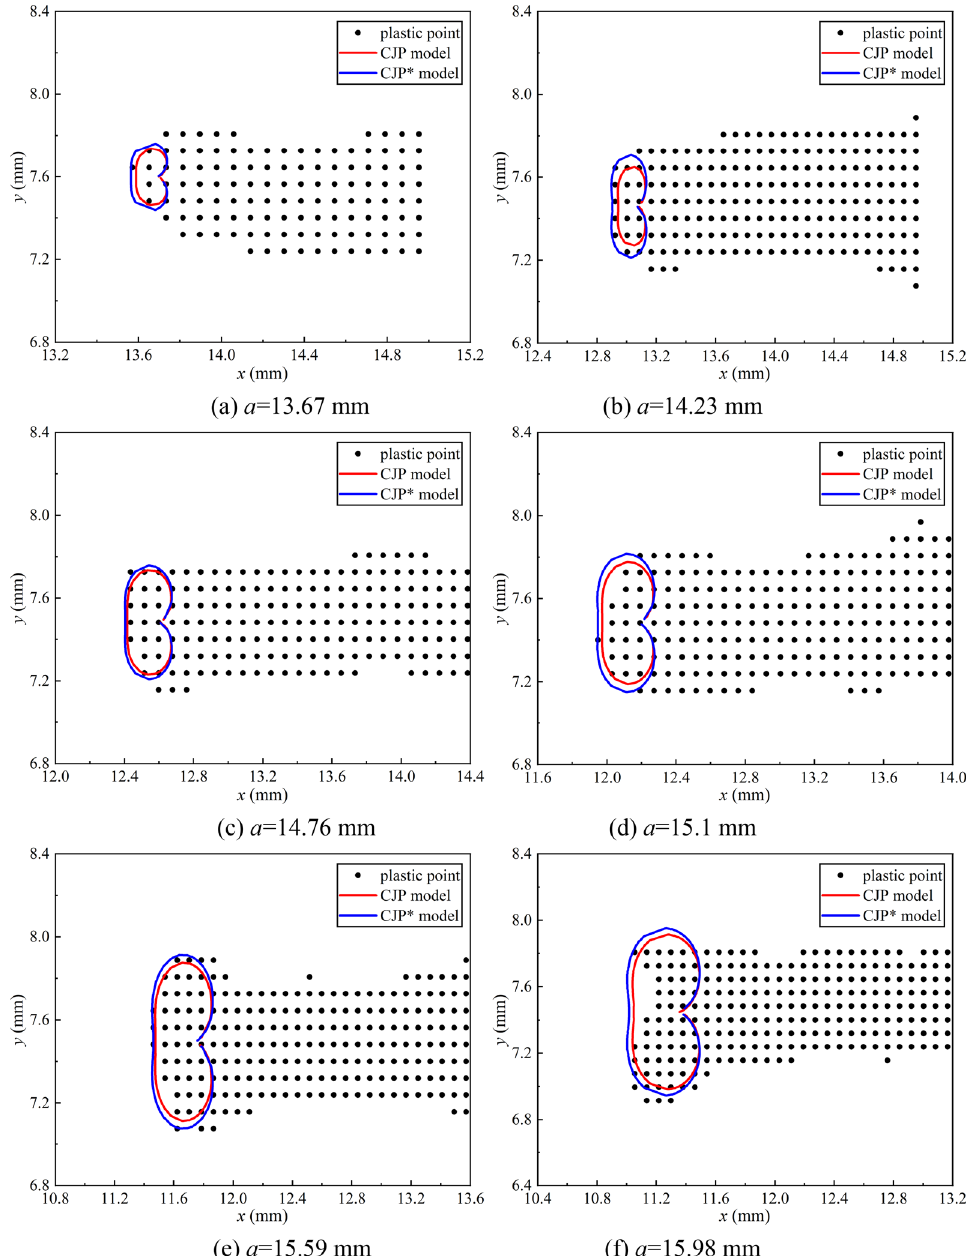
Figure 8 Comparison between the size of the experimental plastic zone and the predictions obtained by the modified CJP (CJP * ) and CJP